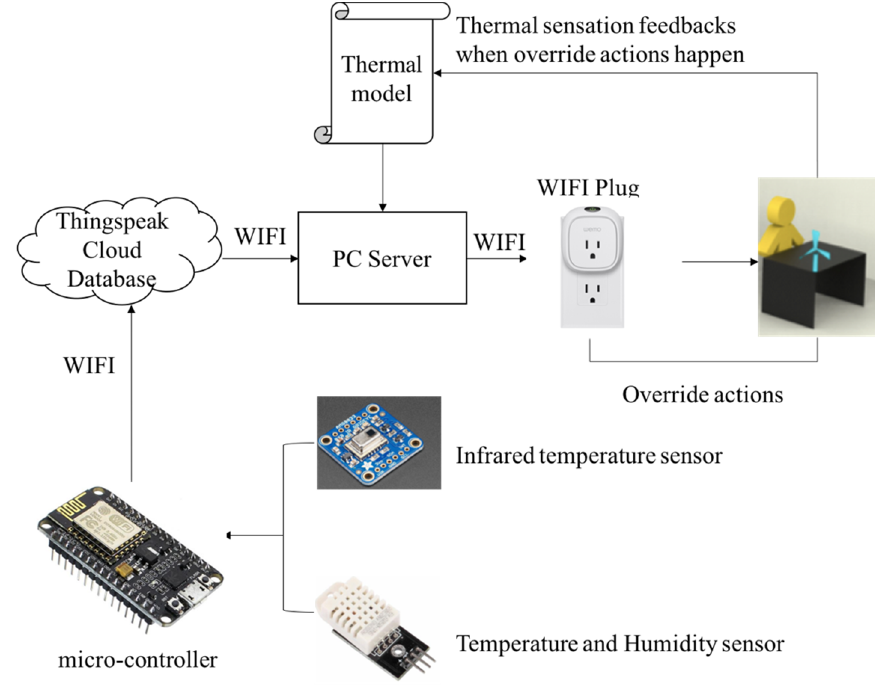
Figure 8. Closed-loop task system diagram of the task conditioning system.